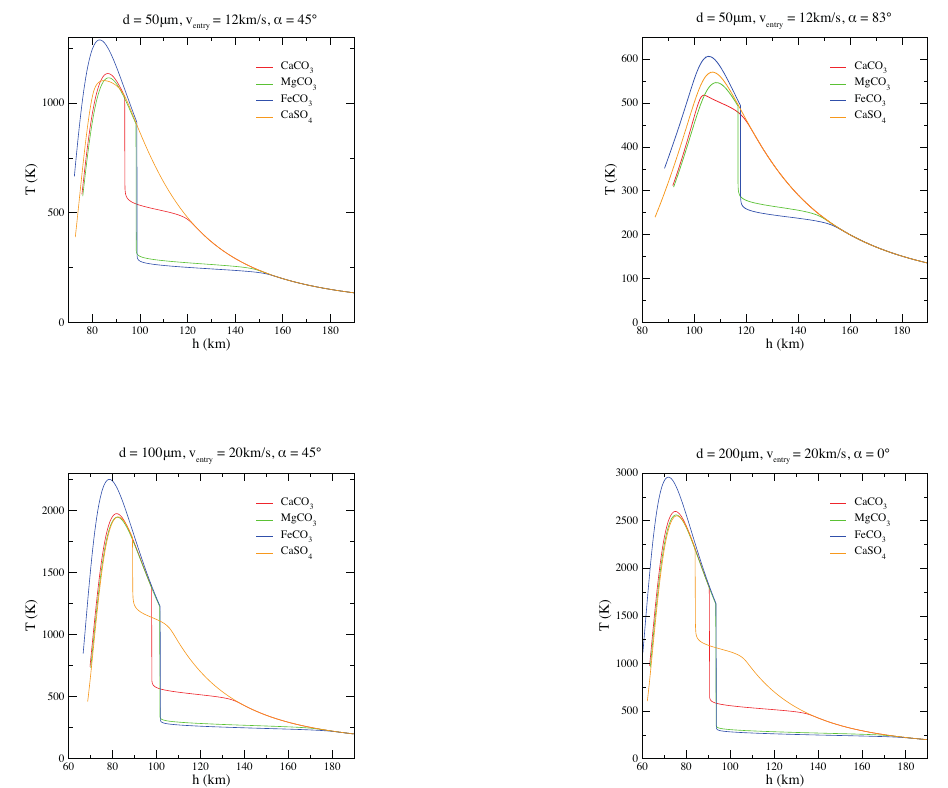
Figure 2. Comparisons among MgCO 3 , CaCO 3 , FeCO 3 , and CaSO 4 micrograin thermal histories for various diameters ( d ), velocities (v entry ), and entry angles ( α ) of the